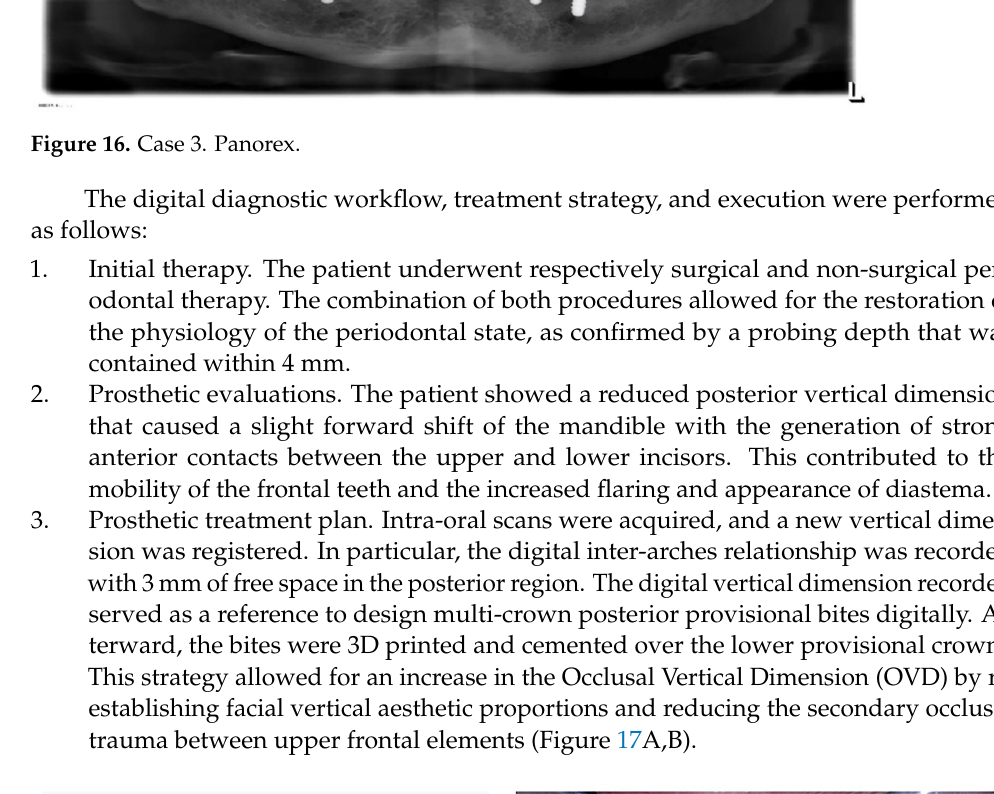
Figure 16. Case 3. Panorex.